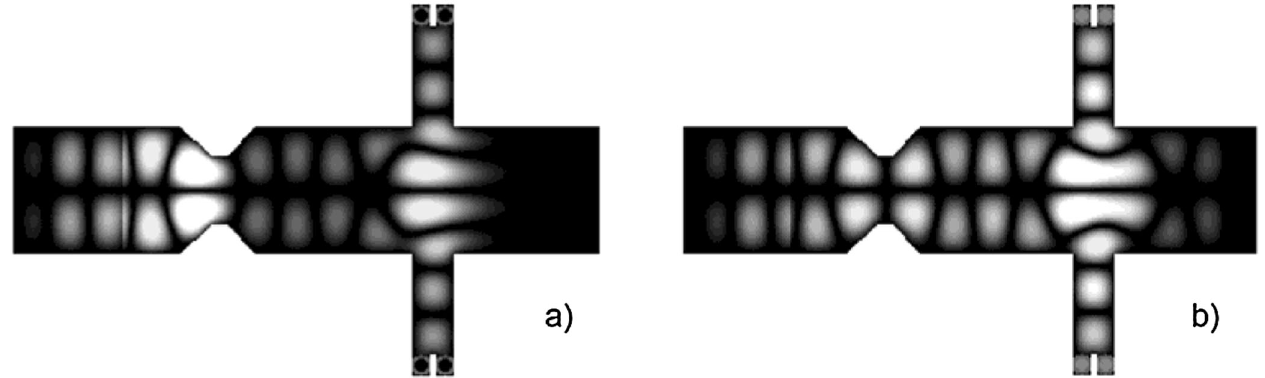
FIG. 3. Instantaneous electric field distributions in plasma switch with two gas-discharge tubes in the (a) energy storage and (b) energy extraction regimes.